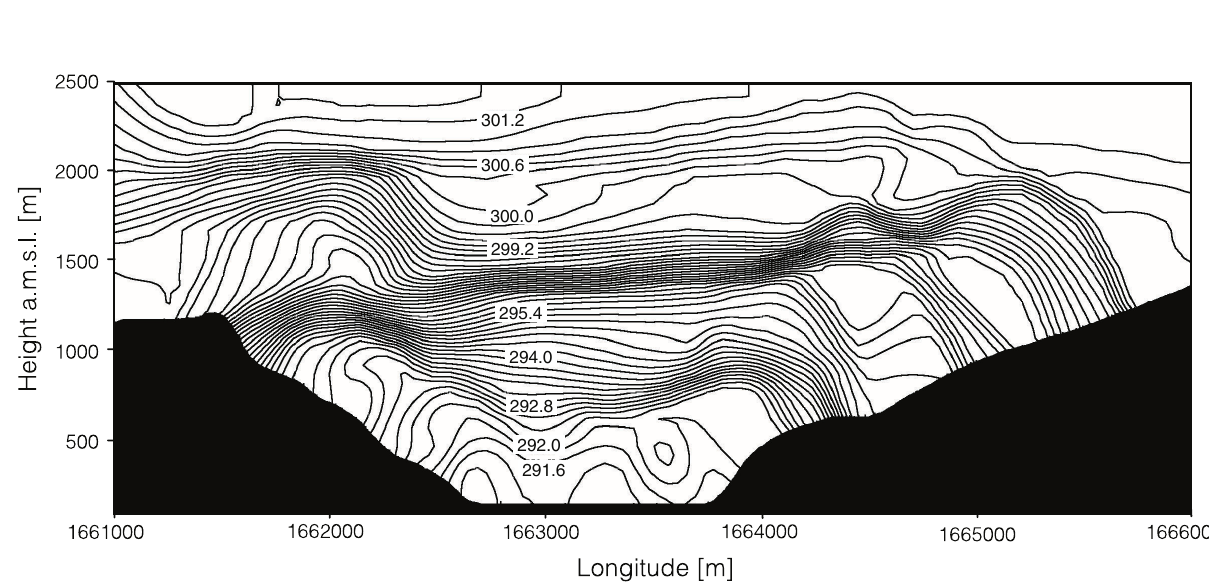
Fig. 9. Mapping of virtual potential temperature q measurements collected during the fl ight #1.